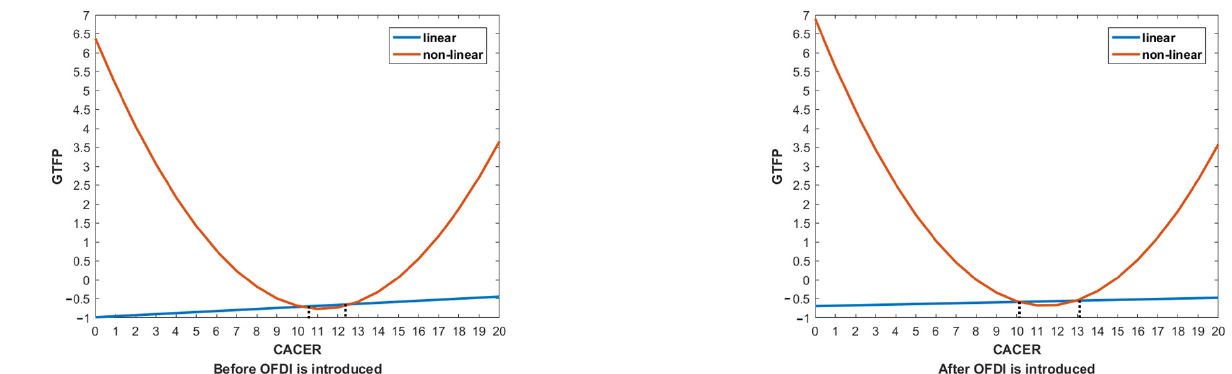
Figure 3. The inflection points for the impact of CACER on GTFP at the national level.